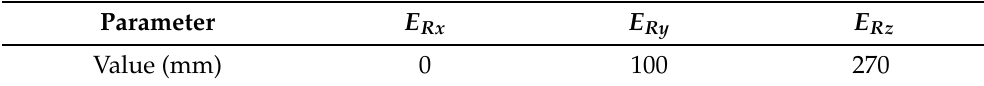
Table 15. Parameters of the VR glasses position’s.